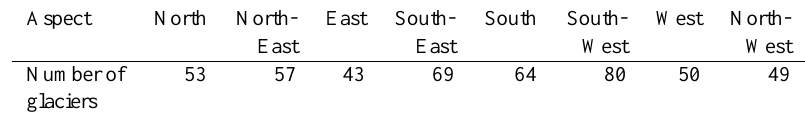
Table 3. Distribution of the aspect of the CV glaciers (based on the Peruvian glacier inventory, 1962). Aspect North North- East South- South South- West North- East East West West Number of 53 57 43 69 64 80 50 49